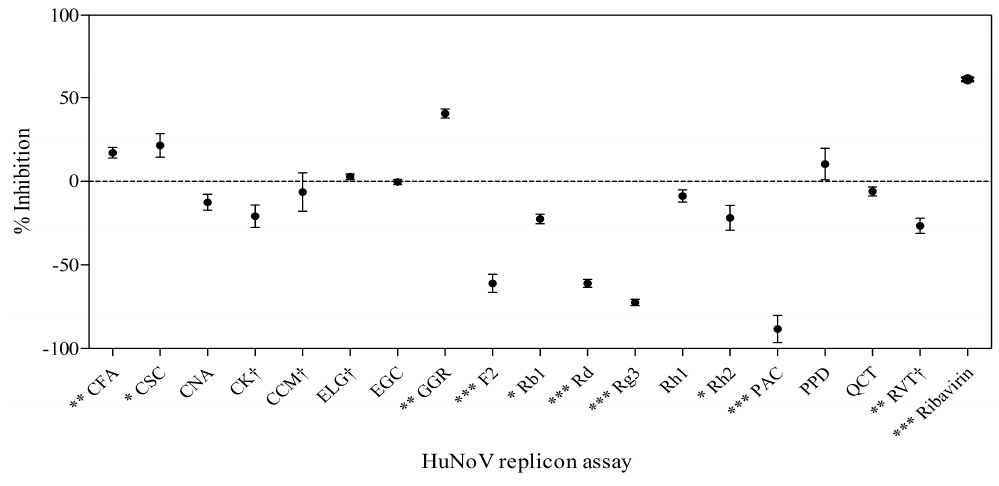
Figure 5. The effect of phytochemicals on human norovirus (HuNoV) replication using a replicon-bearing cell line (HG23). HG23 cells were treated with 20 μ g/mL of phytochemicals and incubated for 72 h at 37 °C. † Treatment concentration is 2 μ g/mL due to cytotoxicity at 20 μ g/mL. Replicons were measured using real-time RT-PCR and normalized with β -actin. DMSO and ribavirin (200 μ M) were used as a vehicle and positive control, respectively. Each point consists of values derived from triplicate determinations. Results are expressed as percentage inhibition (mean ± SEM). Statistical significance was determined based on ANOVA with Bonferroni post-tests. * p < 0.05; ** p < 0.01; *** p < 0.001 comparing to vehicle control.